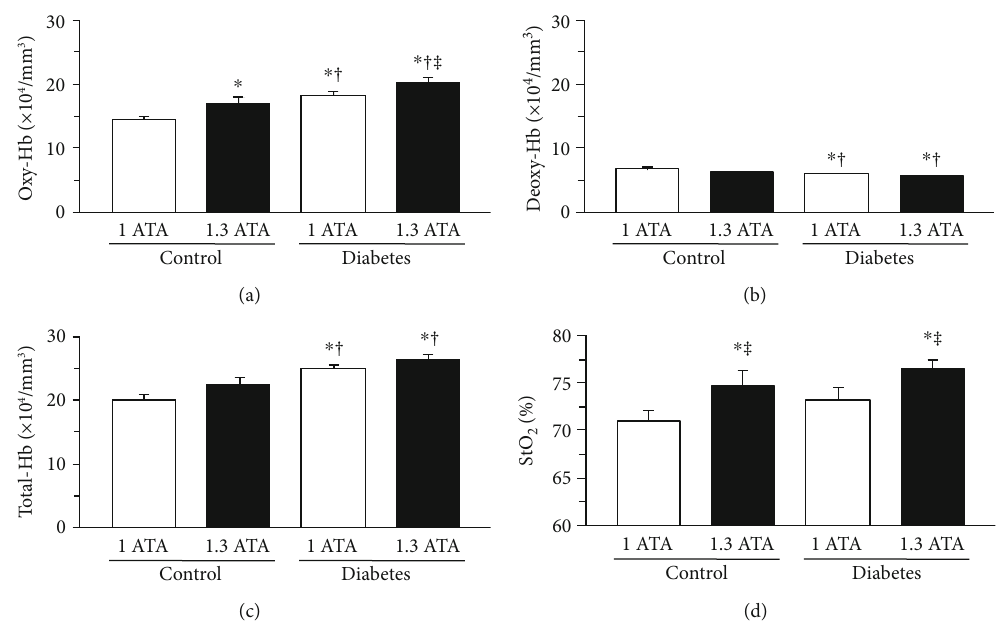
Figure 6: Skeletal muscle hemodynamic response to hyperbaric treatment. Oxy-Hb (a), Deoxy-Hb (b), Total-Hb (c), and StO means ± standard deviation . ∗ , † , ‡ Signi fi cantly di ff erent from the Control, Control HB, and Diabetes groups, p < 0 : 05 ,